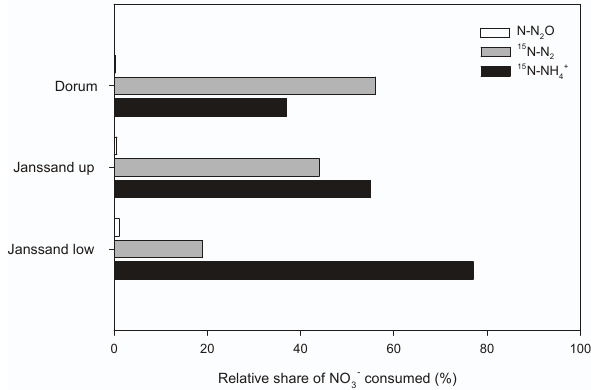
Fig. 4. Nitrogen mass balances of slurred sediments sampled at three coastal marine investigation sites calculated in relative shares of N-NO − consumption. N-NO − consumption rates were set to 3 3 100% and production rates of 15 N-N 2 (indicating DEN activity), 15 N-NH + (indicating DNRA activity), and N-N 2 O were calculated 4